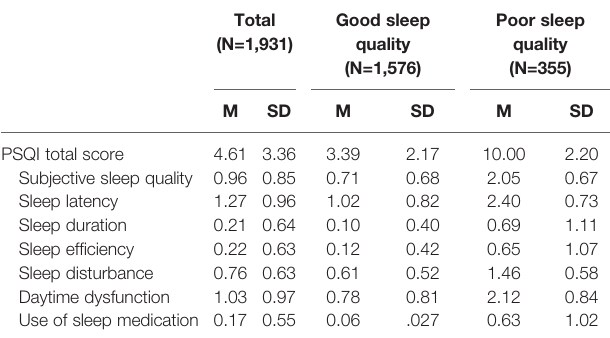
TABLE 2 | PSQI total and component scores in all